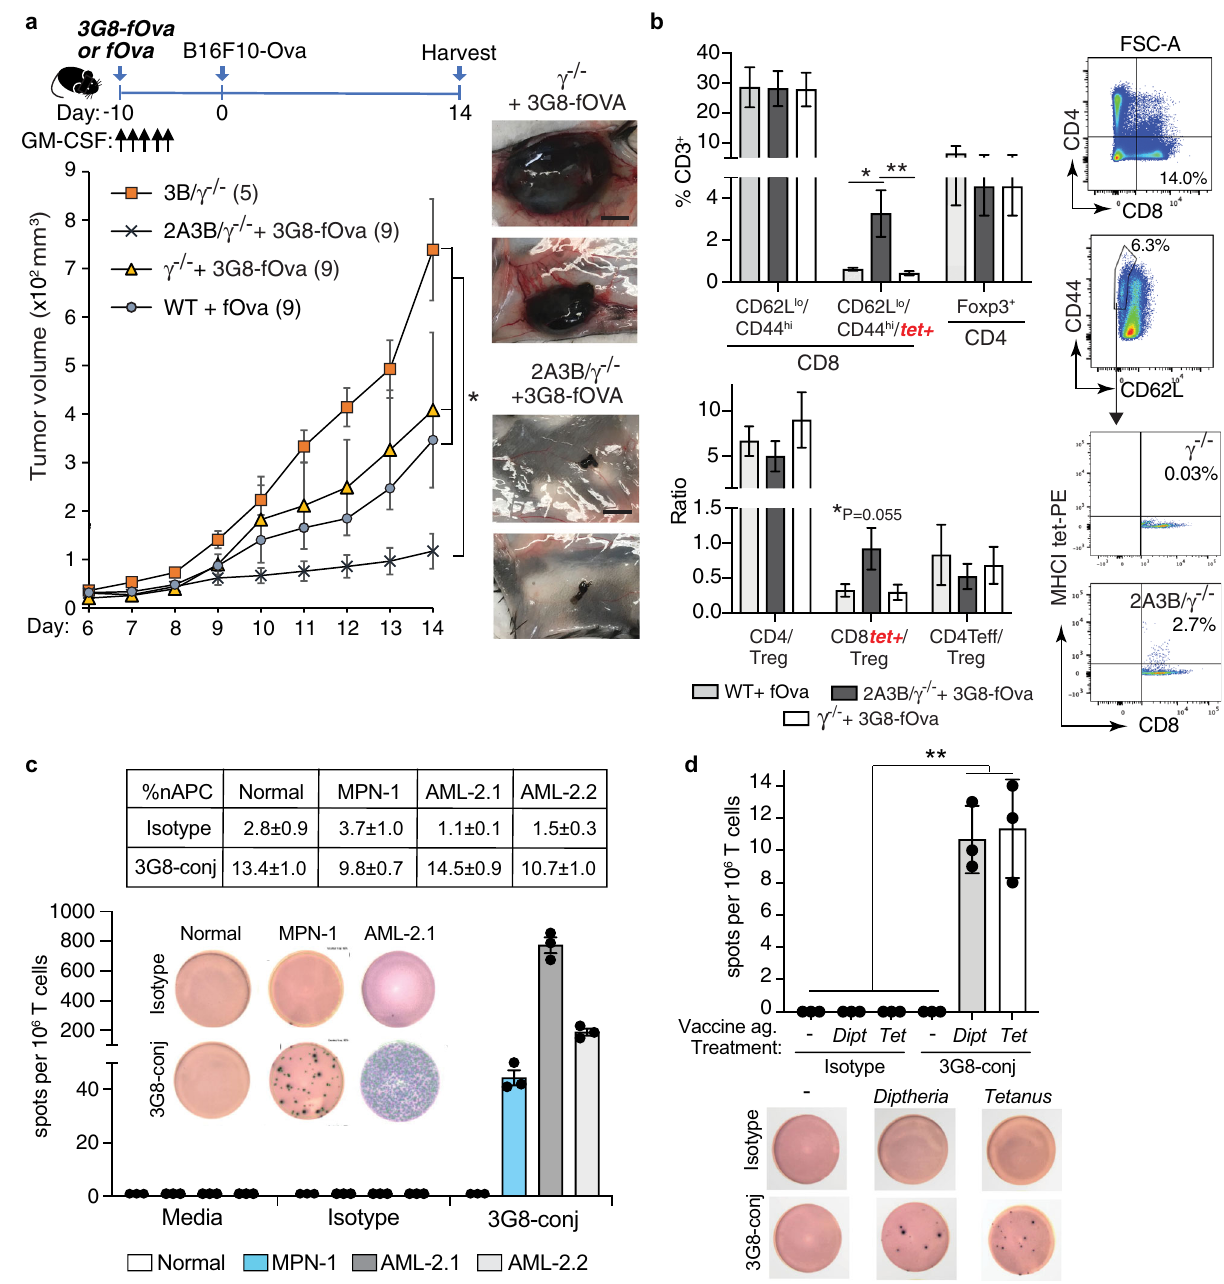
Fig. 7 Anti-Fc γ RIIIB-antigen conjugate is anti-tumorigenic in Fc γ R humanized mice and converts human neutrophils into nAPCs that activate autologous T cells. a , b Schematic for the timeline of indicated treatments for examining the effect of 3G8-fOva on B16F10-Ova tumor growth (top panel). Tumor volume was assessed at indicated times after s.c. injection of B16F10-Ova melanoma cells. The number of mice per group is in parenthesis (lower panel). Representative images of harvested tumors are shown, scale bar = 5 mm ( a ). Spleens of indicated mice from ( a ) at tumor harvest were analyzed for frequency of Ova-peptide speci fi c effector CD8 + T cells (CD62L lo CD44 hi ) using MHCI-tetramers (tet + ), and CD4 + and Treg (Foxp3 + , CD4 + ) cells ( b ). c Neutrophils from a patient with primary myelo fi brosis (a myeloproliferative neoplasm, MPN) or acute myeloid leukemia (AML) (AML-2.1, AML- 2.2 representing two independent blow draws) were treated with 3G8-conjugate (3G8-fOva) or isotype, cultured for 2 days and then co-cultured with autologous T cells and analyzed for IFN- γ secretion on a human IFN- γ ELISpot plate. The percent nAPC generation is shown in the table (avg ± s.e.m.). T cell responses quanti fi ed as the number of spots per 1 × 10 6 cells on a human IFN- γ ELISpot plate is reported and representative images of the same are shown. d Autologous T cell responses against diphtheria toxin (Dipt) or tetanus toxoid (Tet) loaded isotype or 3G8-fOva (3G8-conj) treated neutrophils from normal human volunteers were evaluated using an IFN- γ ELISpot plate as in ( c ). Representative images are shown. Data are mean ± s.e.m. One-way analysis of variance and Dunnett ’ s multiple comparison test was used for comparison of multiple groups except for a), for which statistical analysis is described in Supplementary Fig. 7a. * p < 0.05, ** p <